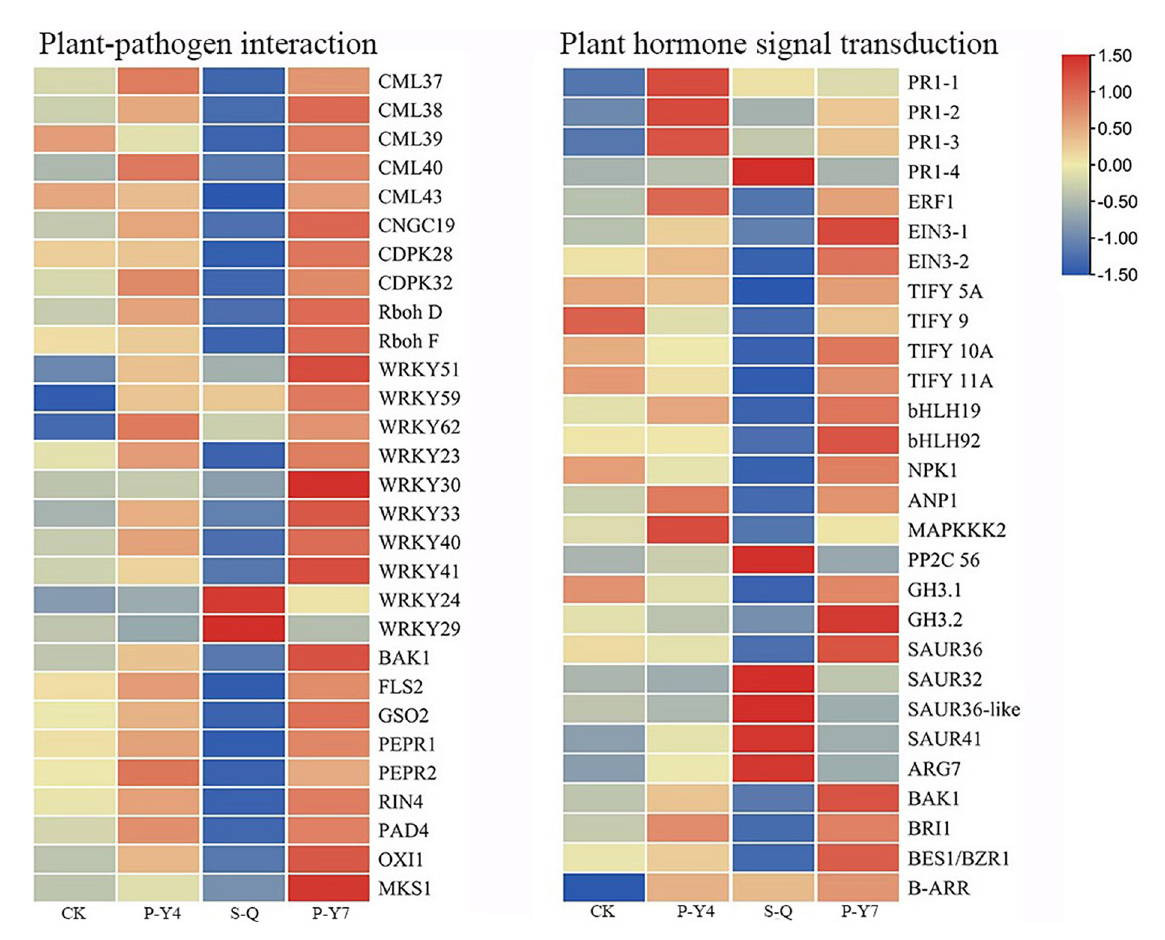
FIGURE9 Heatmaps of differentially expressed genes in cabbage after primary zoospore and secondary zoospore inoculation. CK represents the control, P-Y4 represents gene expressions in cabbage at 4 days after resting spore inoculation, S-Q represents gene expressions in cabbage at 4 days after secondary zoospore inoculation, and P-Y7 represents gene expressions in cabbage at 7 days after resting spore inoculation.